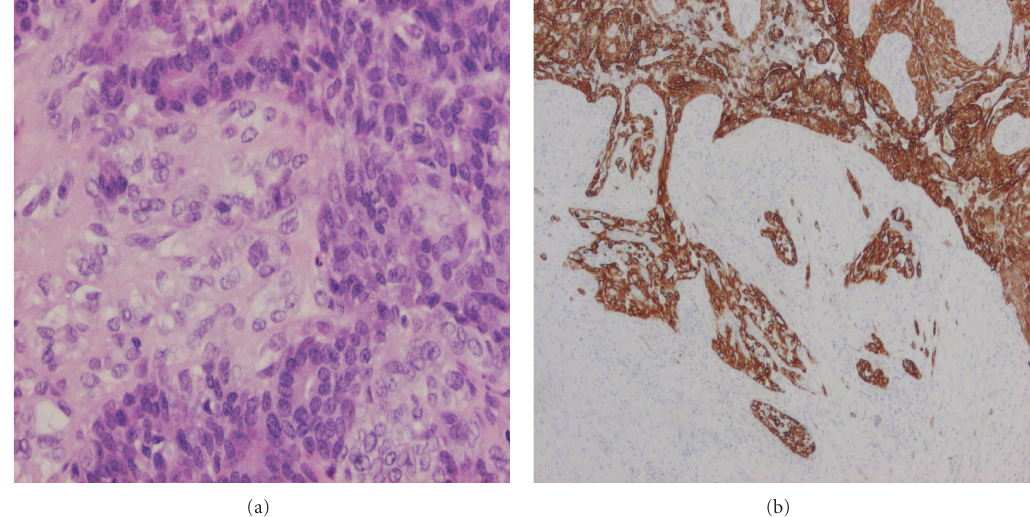
Figure 2: (a) Malignant component: solid area stained with H&E showing dual-cell population with marked nuclear pleomorphism. (b) Malignant component: invasive edge of the lesion stained with cytokeratin